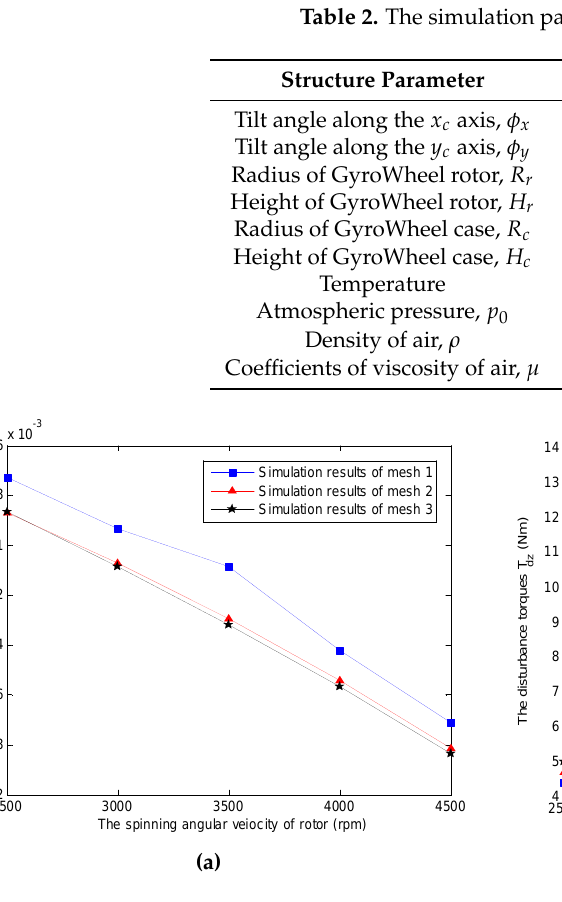
Figure 6. Mesh independence tests under φ x = 0 ◦ and φ y = 0 ◦ (numbers of mesh1, mesh2 and mesh3 are 271,399, 1,217,196 and 1,987,570, respectively). ( a ) Simulation results of T dy ; ( b ) Simulation results of T dz